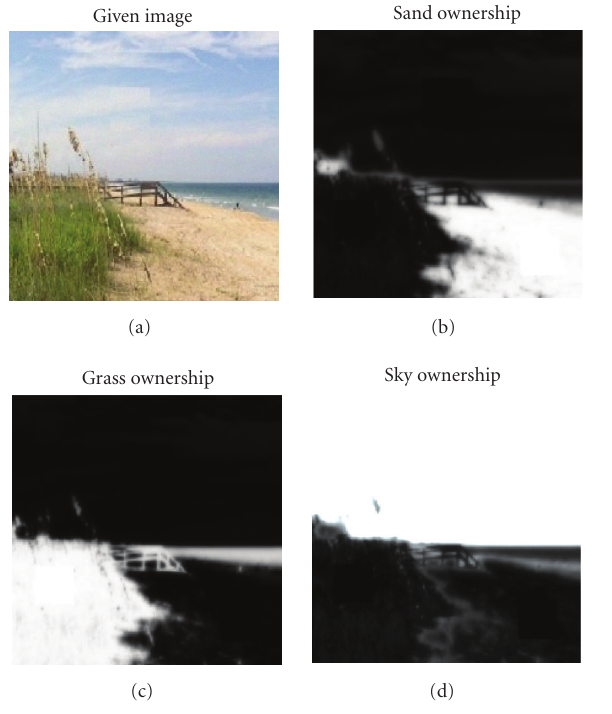
Figure 9: Soft Mumford-Shah segmentation with four phases cor- responding to the supervision on Figure 2(b). Plotted here are the four ownership distributions p 1 ( x ), p 2 ( x ), p 3 ( x ), and p 4 ( x ). Unlike Figure 8, the narrow ocean pattern is now softly segmented due to the extra fourth patch Q 4